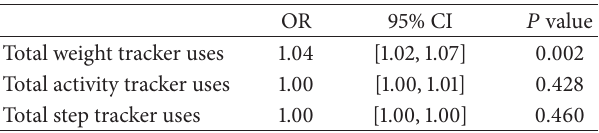
Table 3: Logistic regression predicting ≥ 5% weight loss at 6 months by web tools.